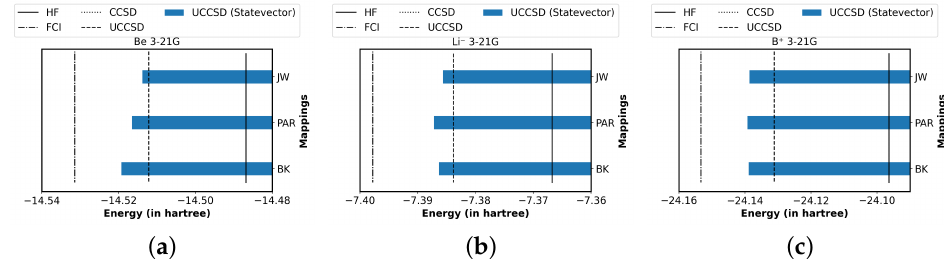
Figure 6. Our results for the ground state energies of the ( a ) Be, ( b ) Li − , and ( c ) B + in 3-21G basis using different combinations of mappings and backend simulators visualized as bar plots. The notations that have been adopted for this figure are the same as those for Figure 3.